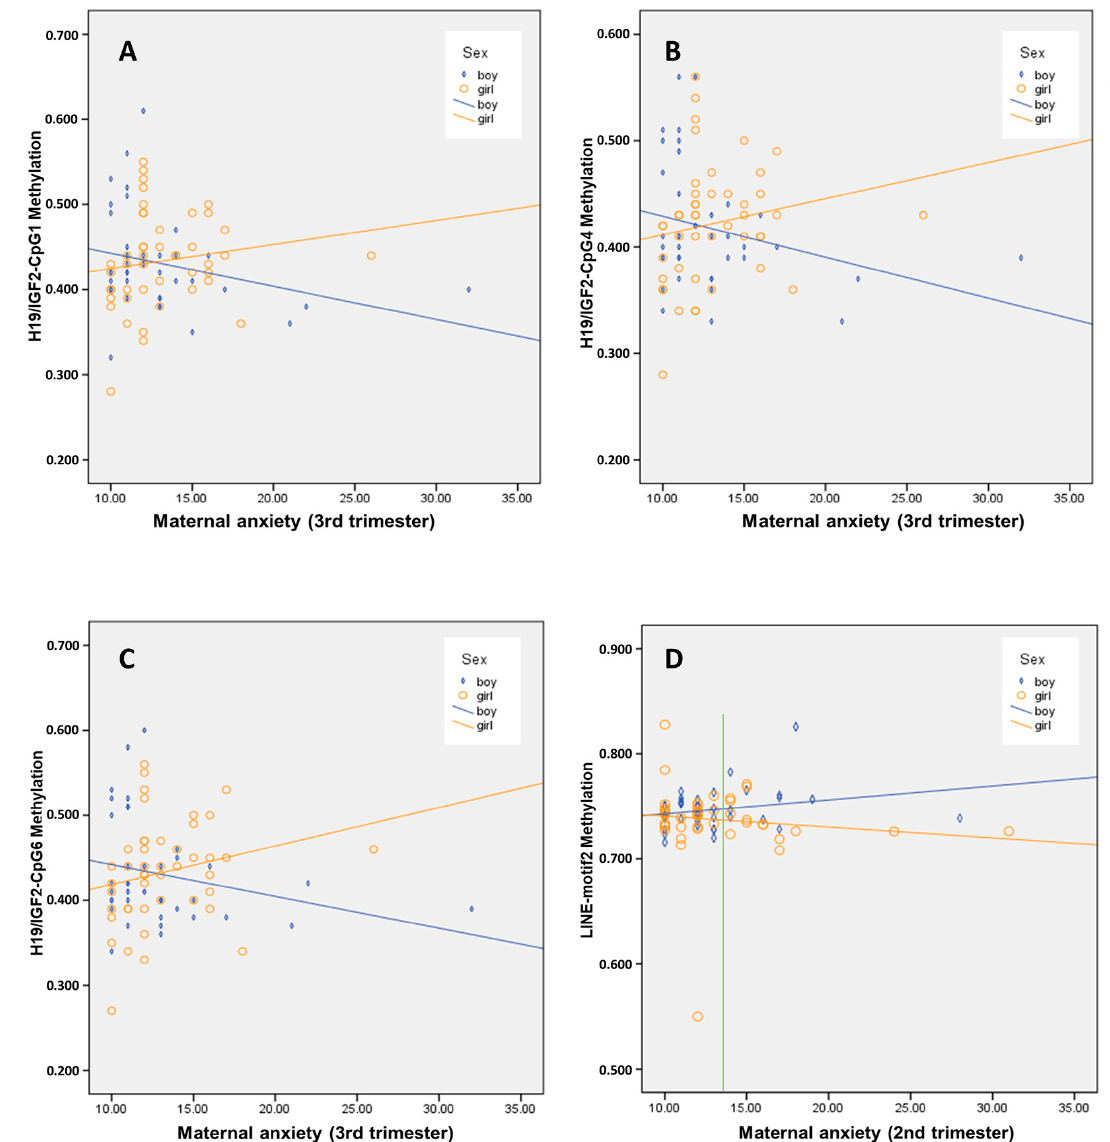
Figure 3. Scatter plots represent sex interaction. Blue squares indicate male and orange circles indicates female. Dashed blue line represents the fitting line in males and orange in females. X-axis represents the maternal anxiety score and Y-axis represents the beta-value of DNA methylation. ( A – C ) For boys, there was a negative association between maternal anxiety during the third trimester and the methylation level of IGF2/H19 CpGs; for girls, there was a positive association between maternal anxiety during the third trimester and the methylation level of IGF2/H19 CpGs. ( D ) For second trimester maternal anxiety level of 13.42 or higher there was a significant difference in DNA methylation level of LINE1 motif 2 between boys and girls ( p < 0.05). Green line indicates the value of 13.42.